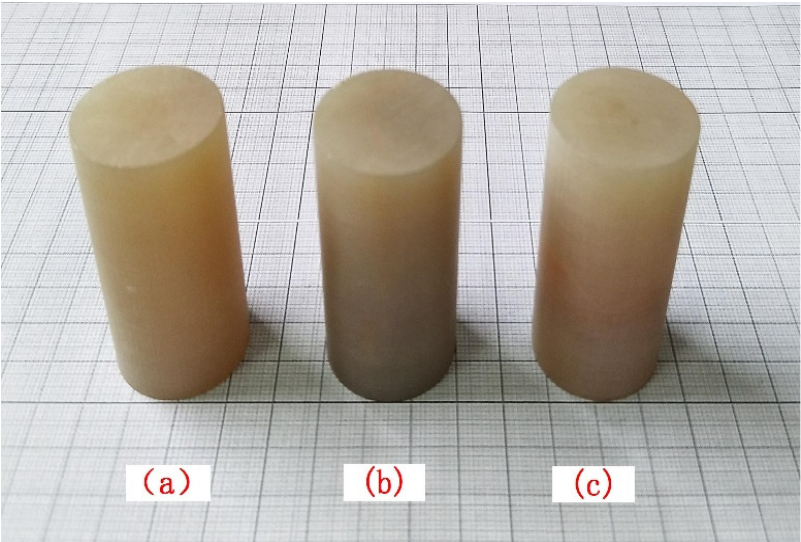
Figure 1. The crystal boules grown by the vertical Bridgman process from the polycrystalline materials with the composition ratios of ( a ) 0.01PSN-0.69PMN-0.30PT ( b ) 0.02PSN-0.68PMN-0.30PT and ( c ) 0.03PSN-0.67PMN-0.30PT.